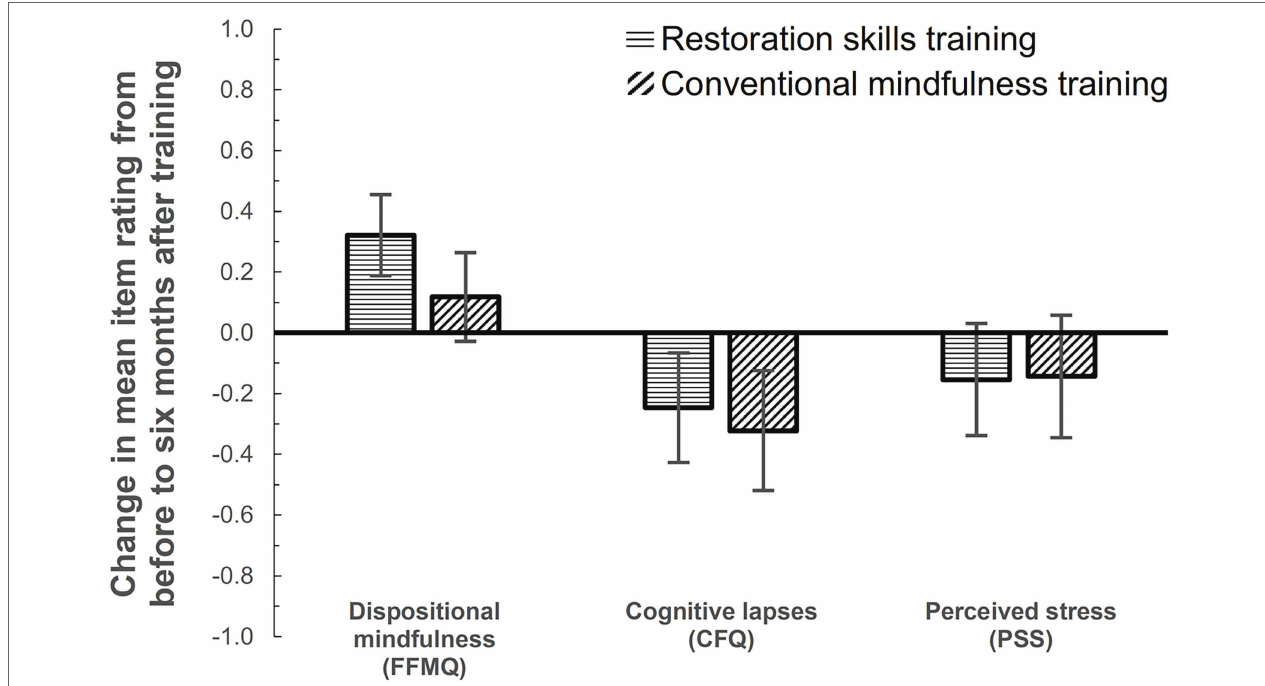
FIGURE 2 | Average levels (estimated marginal means) and 95% CIs of change observed in the 6-month follow-up compared to the initial assessments before the course started, for mean item ratings of dispositional mindfulness (Five Facet Mindfulness Questionnaire; possible range 1–5), cognitive lapses (Cognitive Failures Questionnaire; possible range 0–4), and perceived stress (Perceived Stress Scale; possible range 0–4). Pretest scores obtained before the course on the respective measures were entered as covariates. The figure reflects the observed data obtained from 37 ReST participants and 31 CMT participants (estimates based on the multiple imputation datasets with N = 97 were very similar).